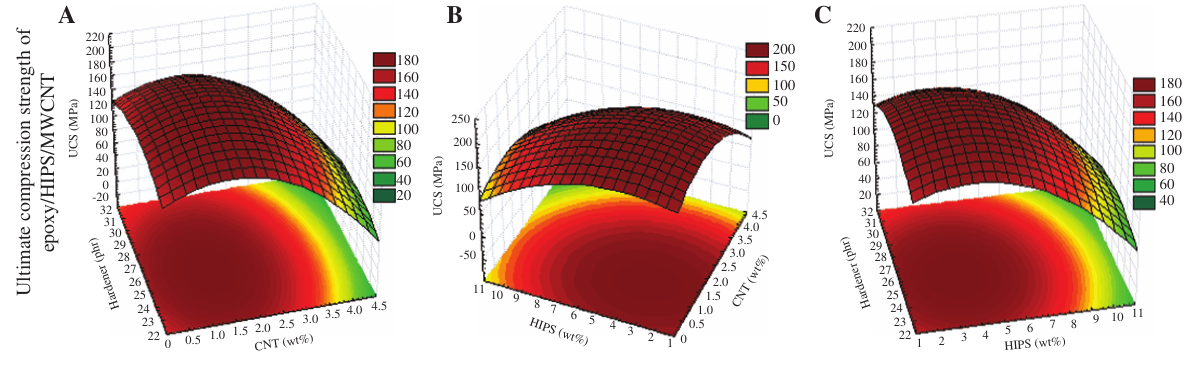
Figure 7 Three-dimensional plots of UCS for (A) HIPS (3.6 wt%), (B) hardener (26 phr) and (C) MWCNT (1.4 wt%).